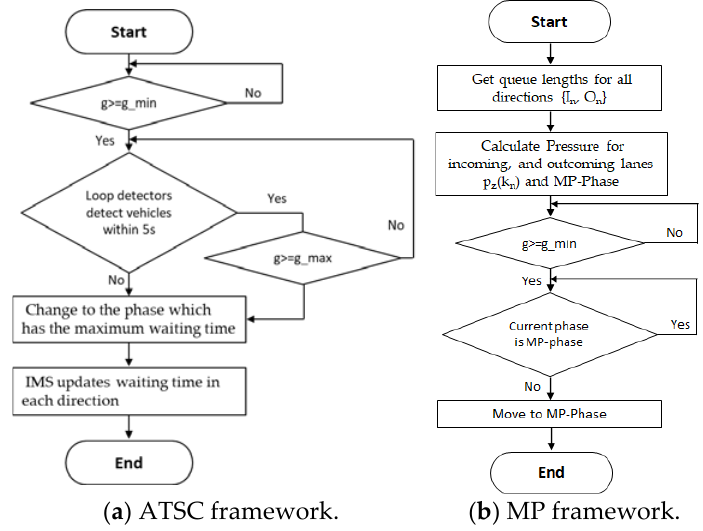
Figure 9. Frameworks of ATSC- and MP-based scenarios.